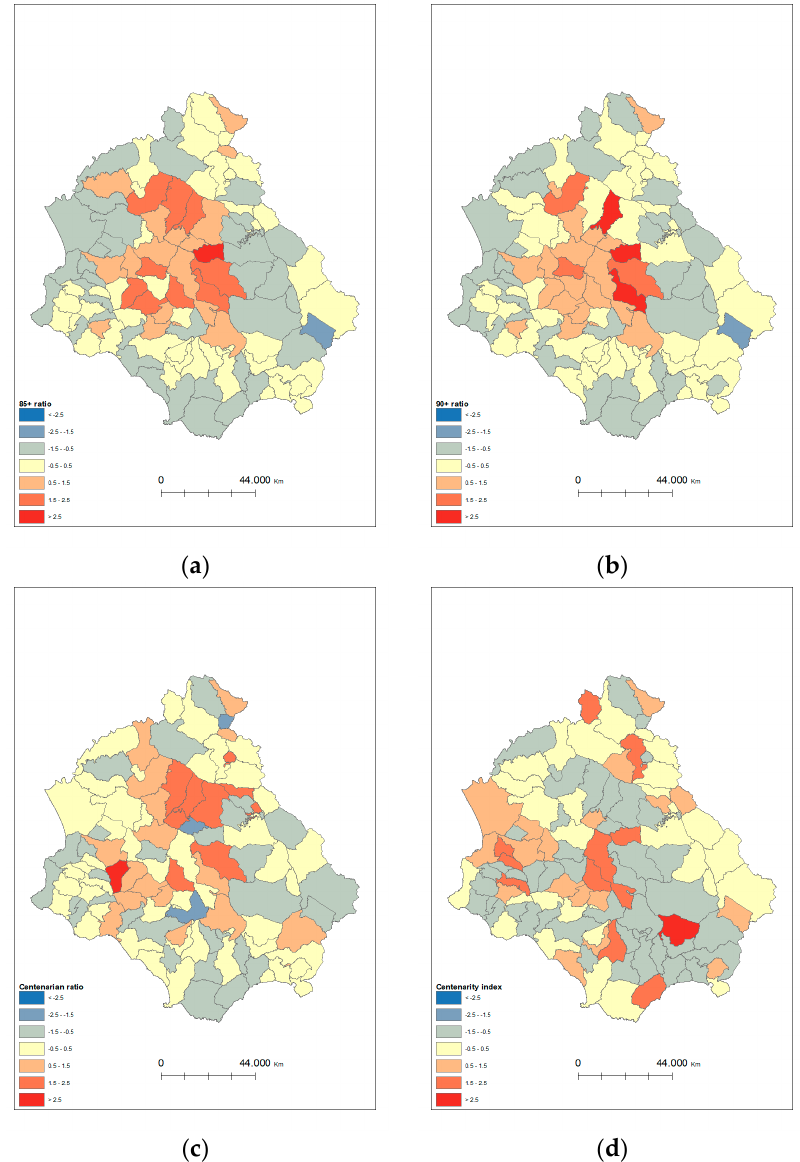
Figure 3. Results of the GWR models for 85+ ratio, 90+ ratio, centenarian ratio and centenarity index showing the local R2. Note: ( a ) local R2 for 85+ ratio; ( b ) local R2 for 90+ ratio; ( c ) local R2 for centenarian ratio; ( d ) local R2 for centenarity index. GWR—geographically weight regression.